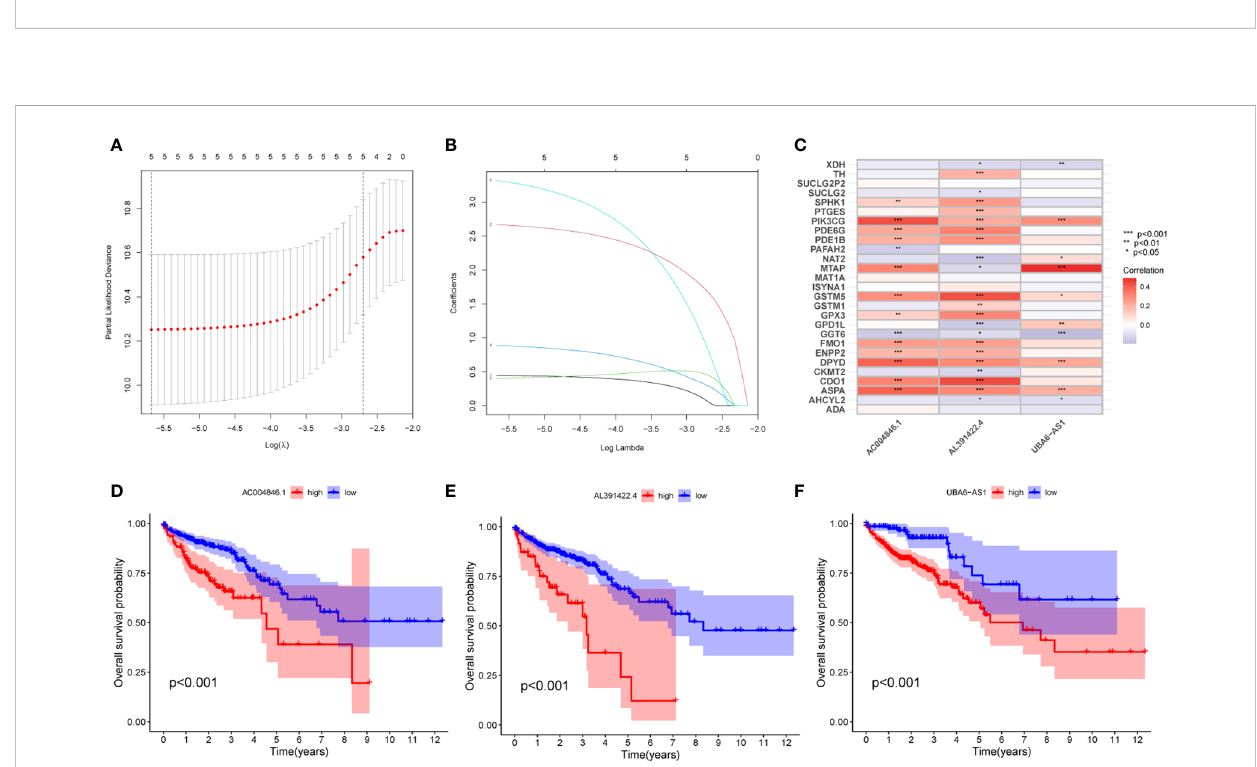
FIGURE 3 Construction of MRLncRI. (A, B) LASSO analysis of prognosis-related lncRNA. (C) Correlation heat map of HMRGs and hub lncRNA. (D – F) Kaplan-Meier survival curve analysis of hub lncRNA.